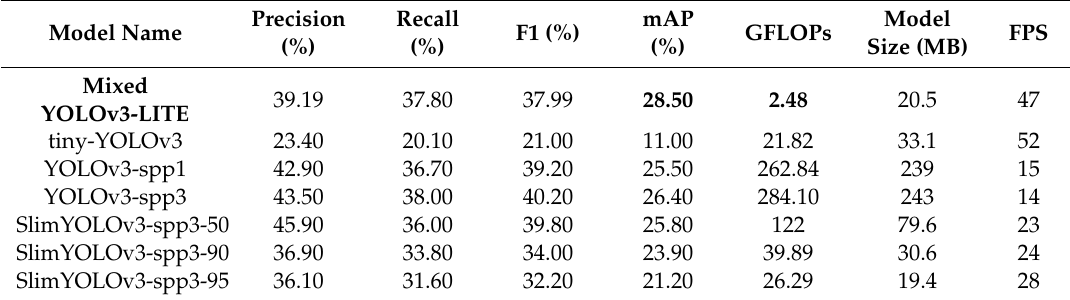
Table 7. Evaluation results for baseline models and Mixed YOLOv3-LITE for VisDrone 2018-Det.